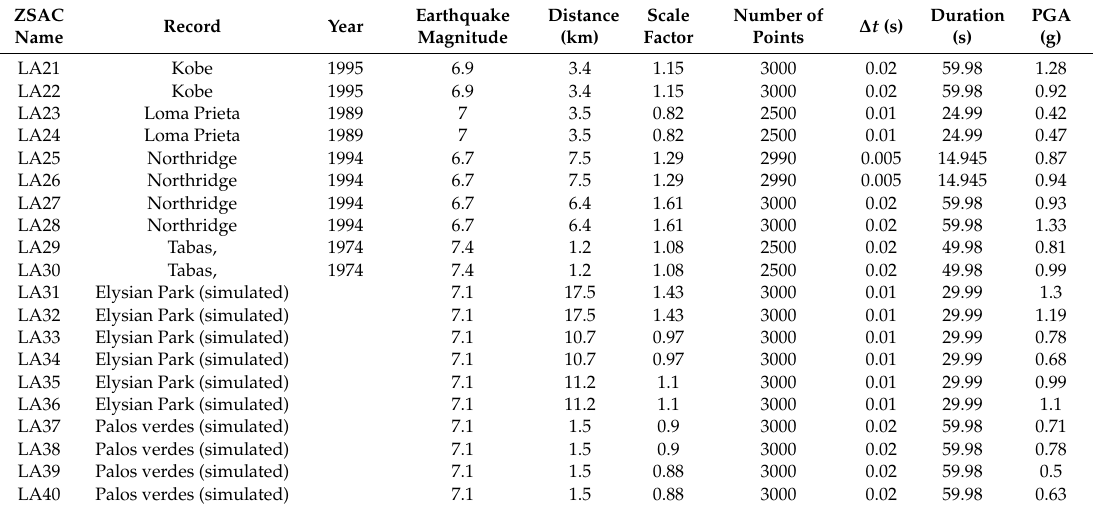
Table 2. List of the maximum considered earthquakes (MCE)-level earthquake ground motions used in the study and the event